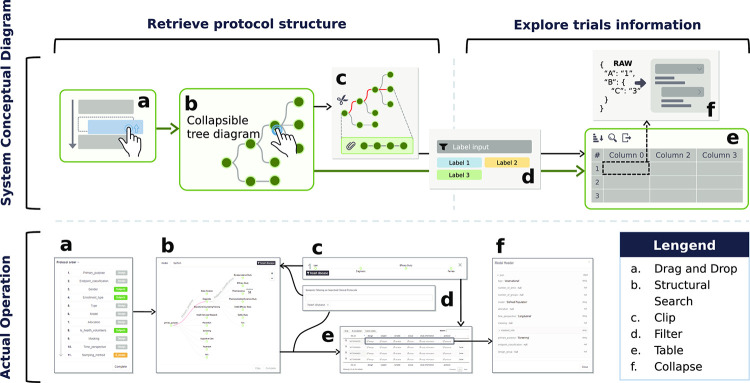
System overview.